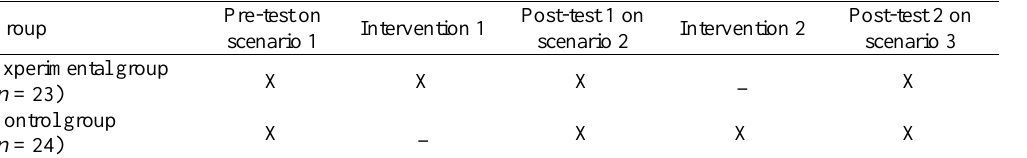
Table 1 The non-randomised control group pre-test/post-test design (adapted from Leedy & Ormrod, 2005:227)